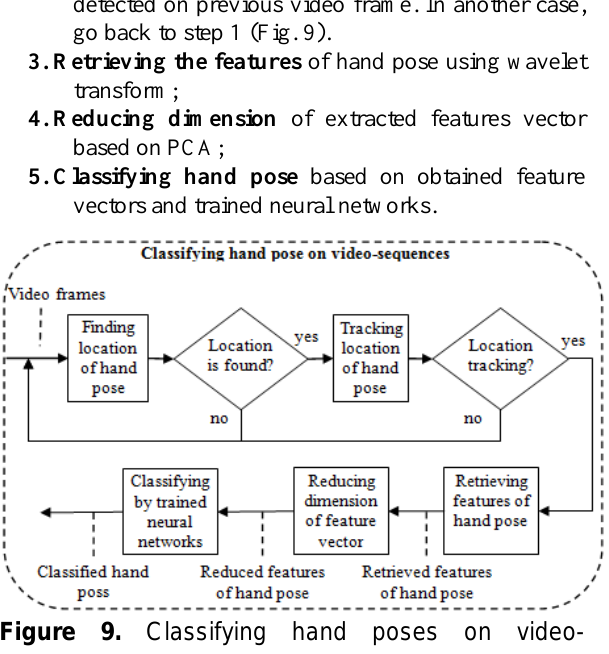
Figure 9. Classifying hand poses on video-